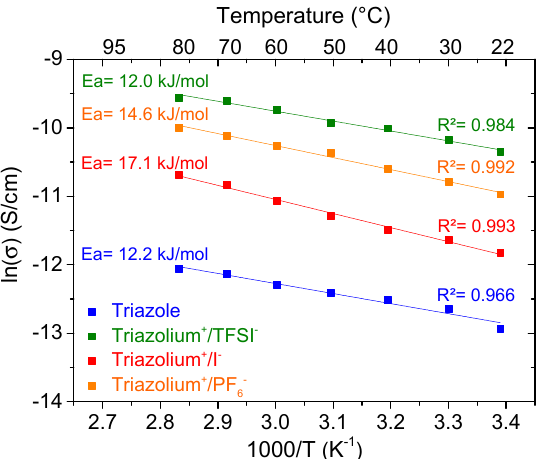
Figure 6. Temperature-dependent conductivity of each gel swollen with EC / DEC (1 / 1) and comprising 2.4 mol % of crosslinker. The cells are composed of stainless steel | PTMA gel | stainless steel.